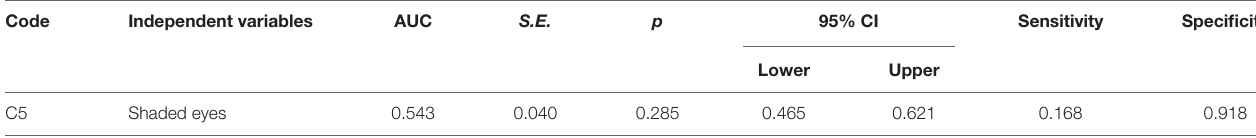
TABLE 5 | Results of ROC curve analysis of drawing features positively associated with depression.